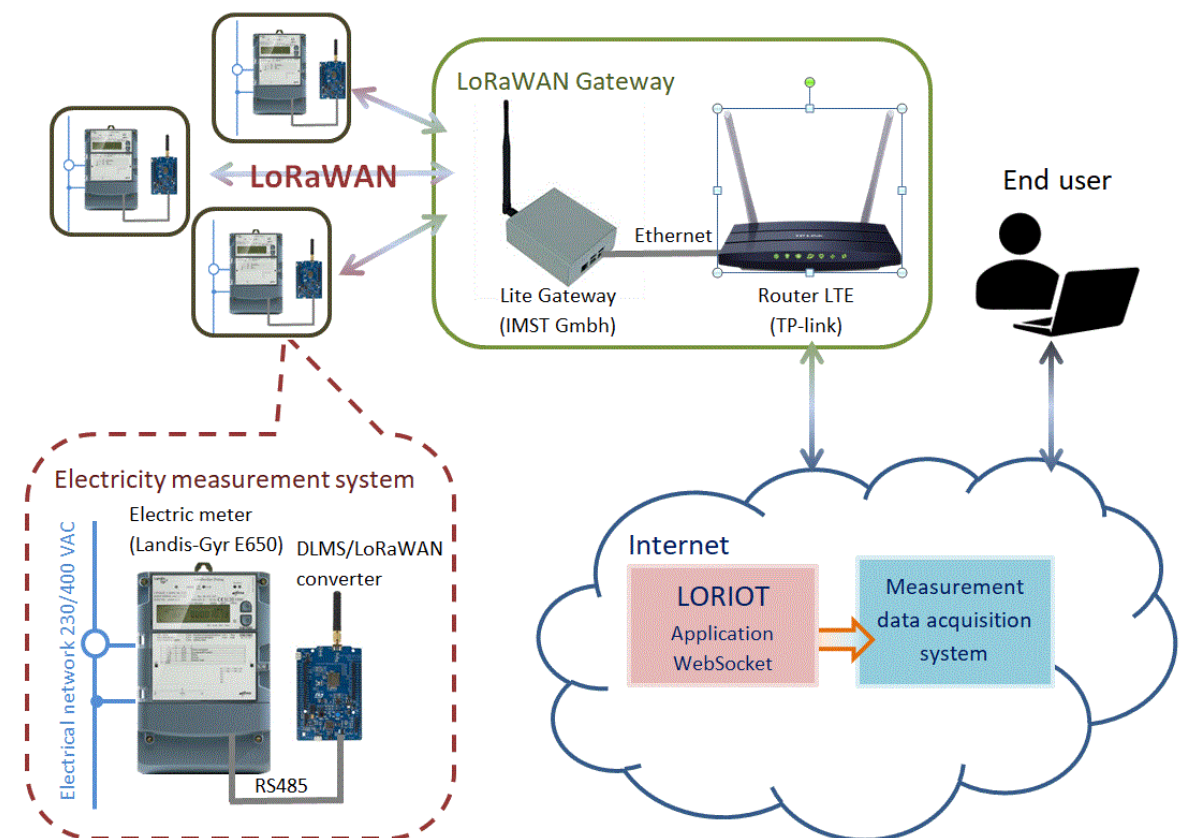
Figure 1. Schema of a communication channel for energy meters reading in LoRaWAN with using DLMS/LoRaWAN converter and LORIOT cloud platform.